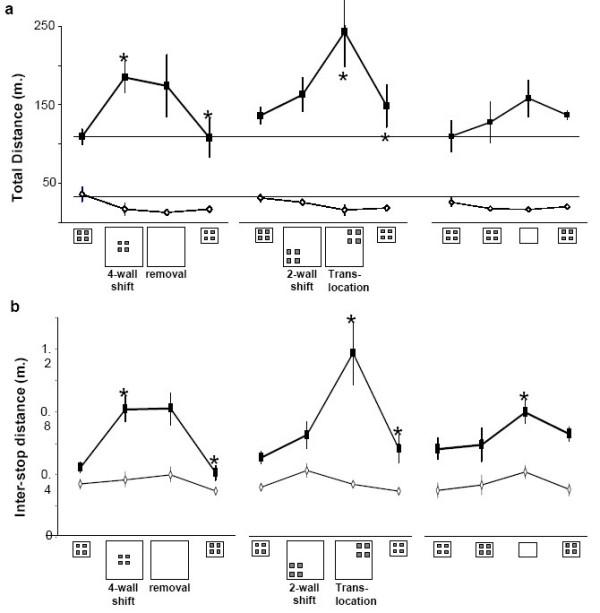
Total distance (a) and interstop distances (b) traveled by quinpirole (dark symbols; thick line) and saline (clear symbols; thin line) treated rats in each of the experimental groups (means ± SEM, in meters). Environmental settings are depicted along the x-axis for each group.